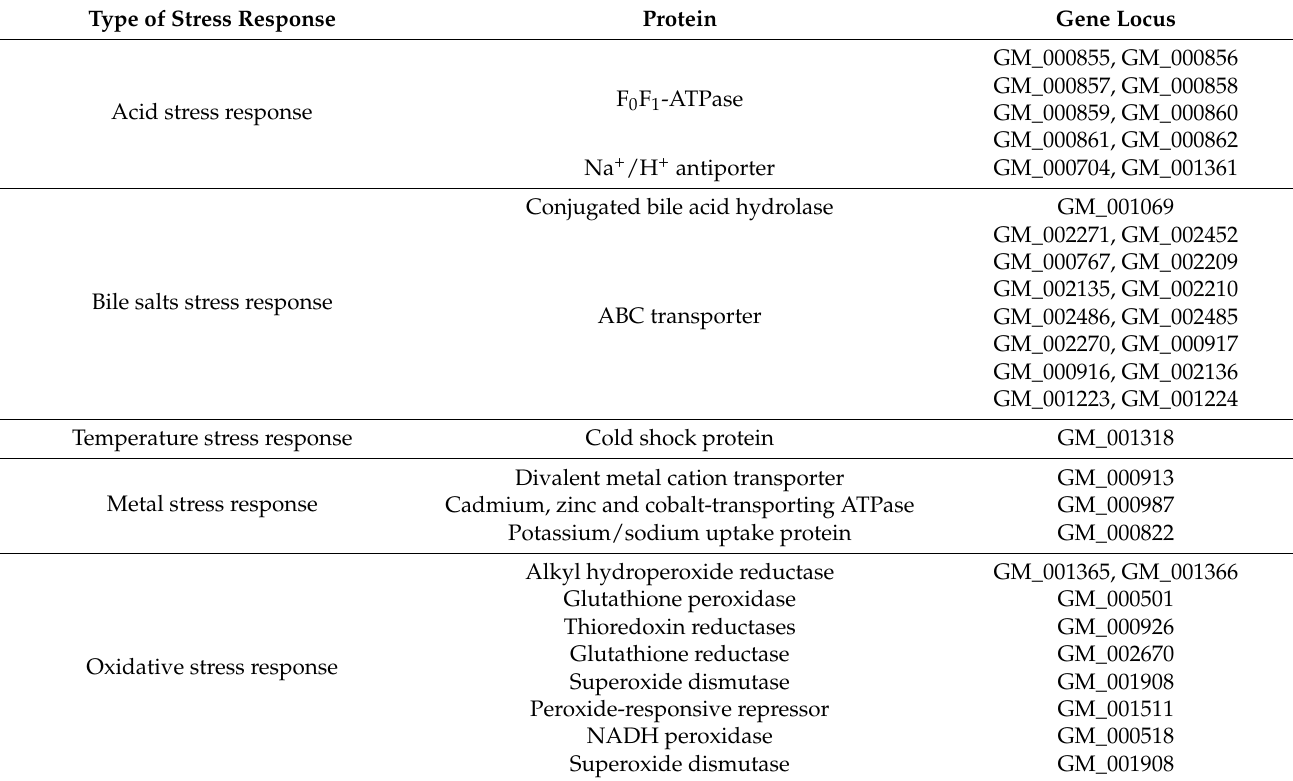
Table A2. Stress-responsive proteins in the whole genome of E. faecium